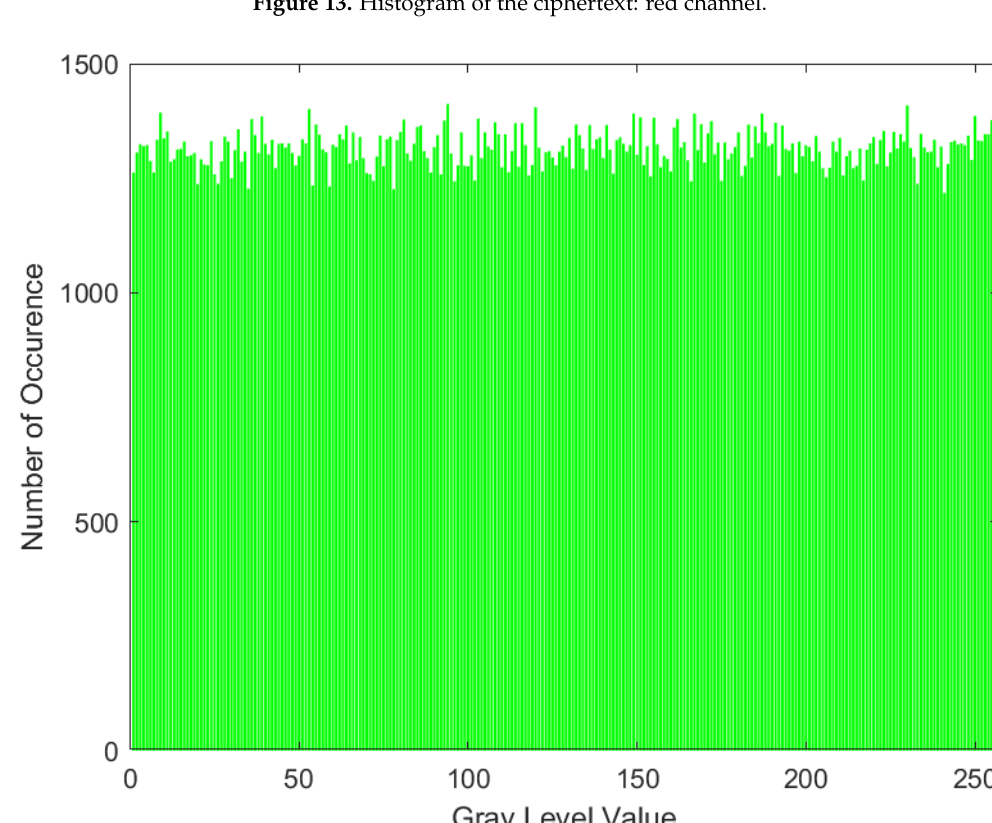
Figure 14. Histogram of the ciphertext: green